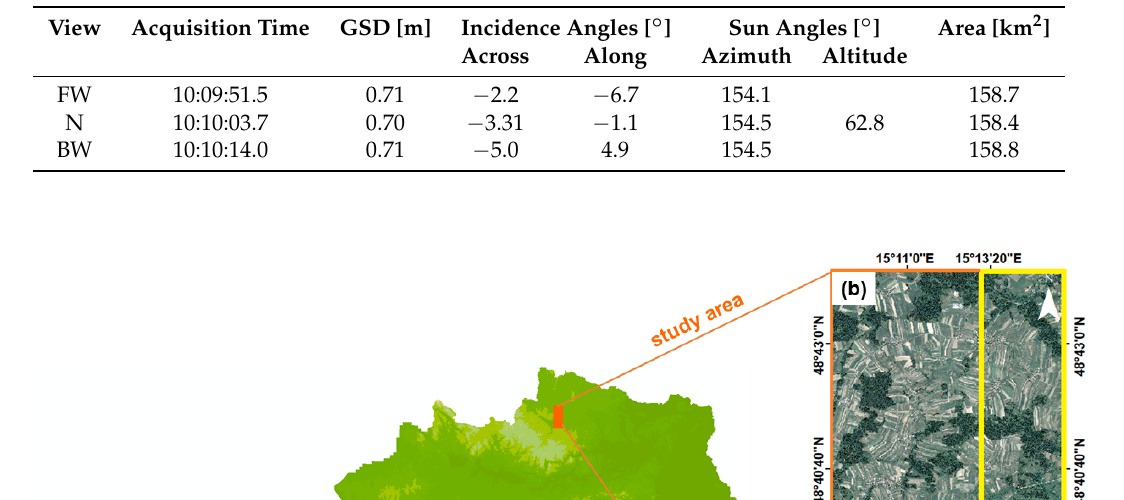
Table 1. Acquisition properties for the satellite images over the study site.